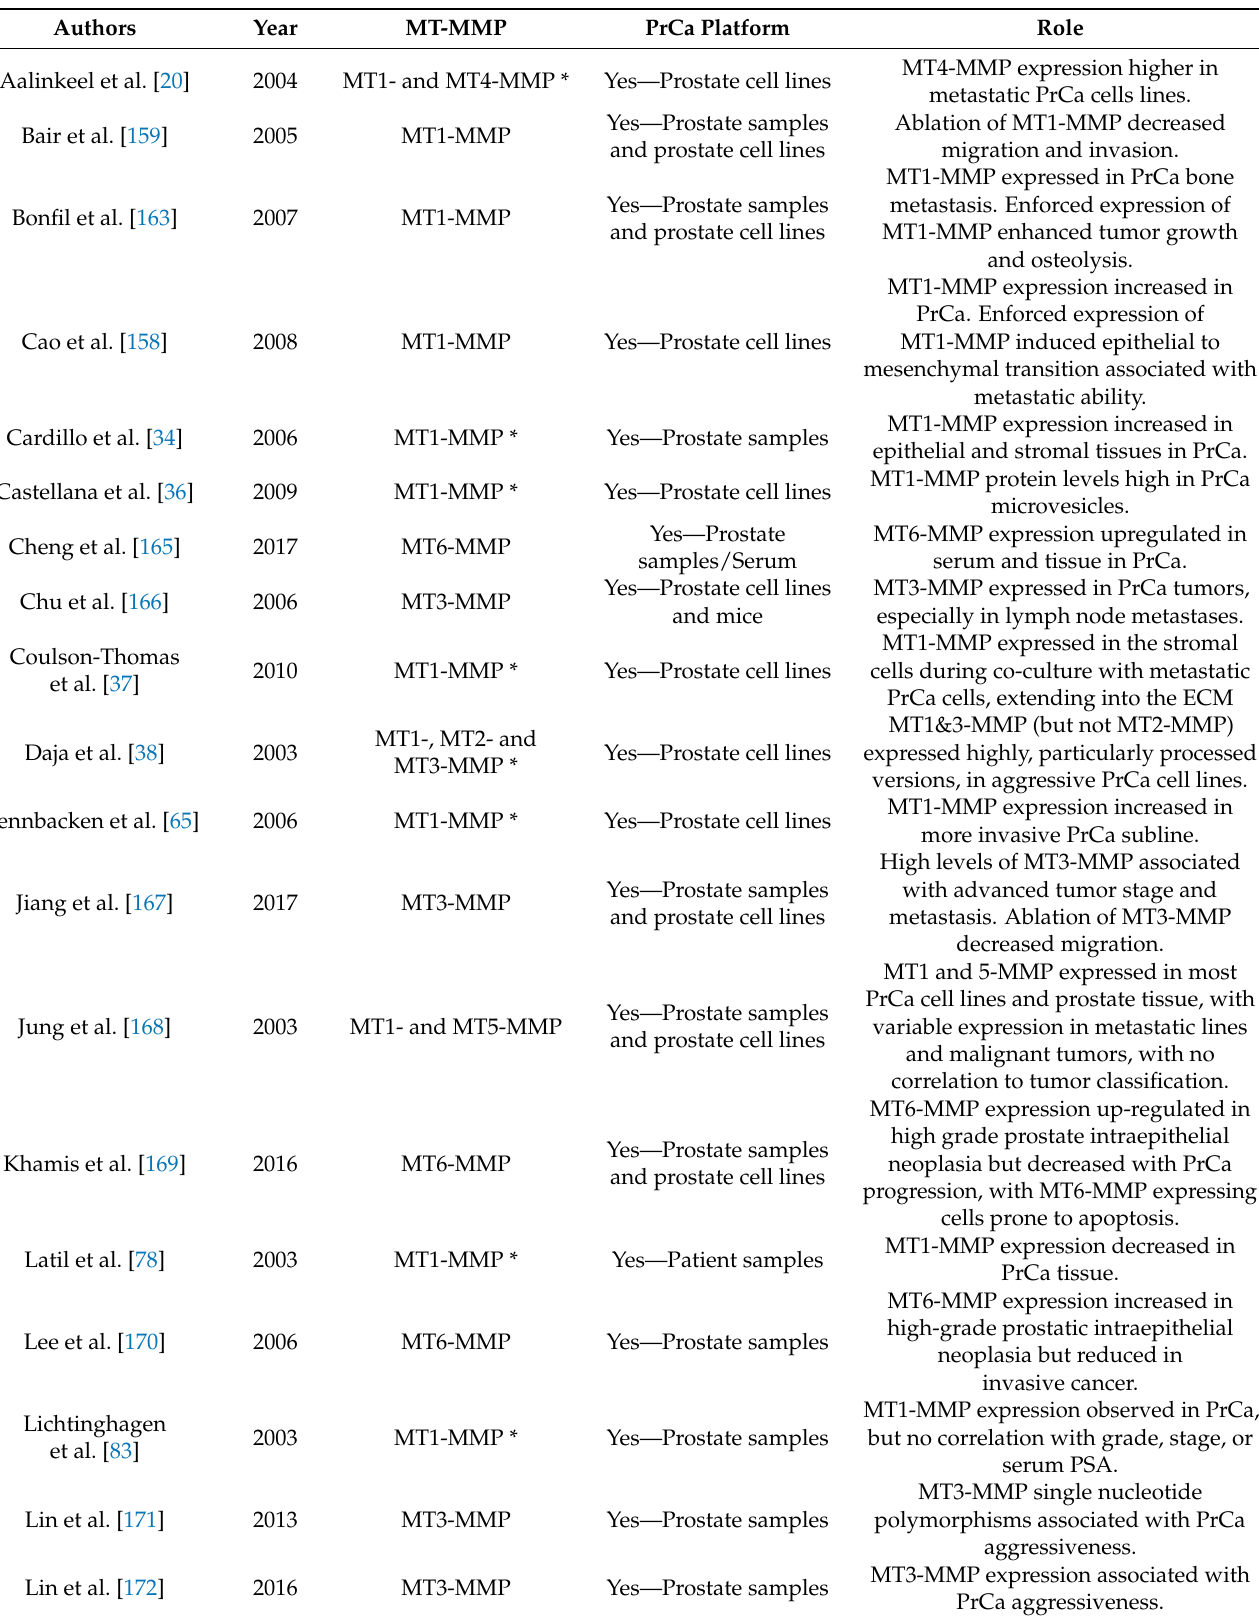
Table 2. Studies on Membrane-Tethered Matrix Metalloproteinase (MT-MMPs) in